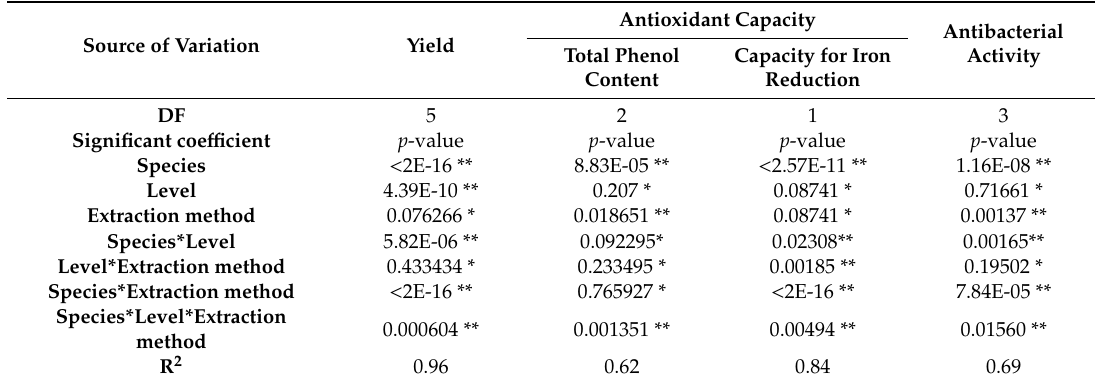
Table 2. Analysis of variance (ANOVA) of di ff erent factors and their e ff ect on EO yield, total phenol content, capacity for iron reduction, and antibacterial